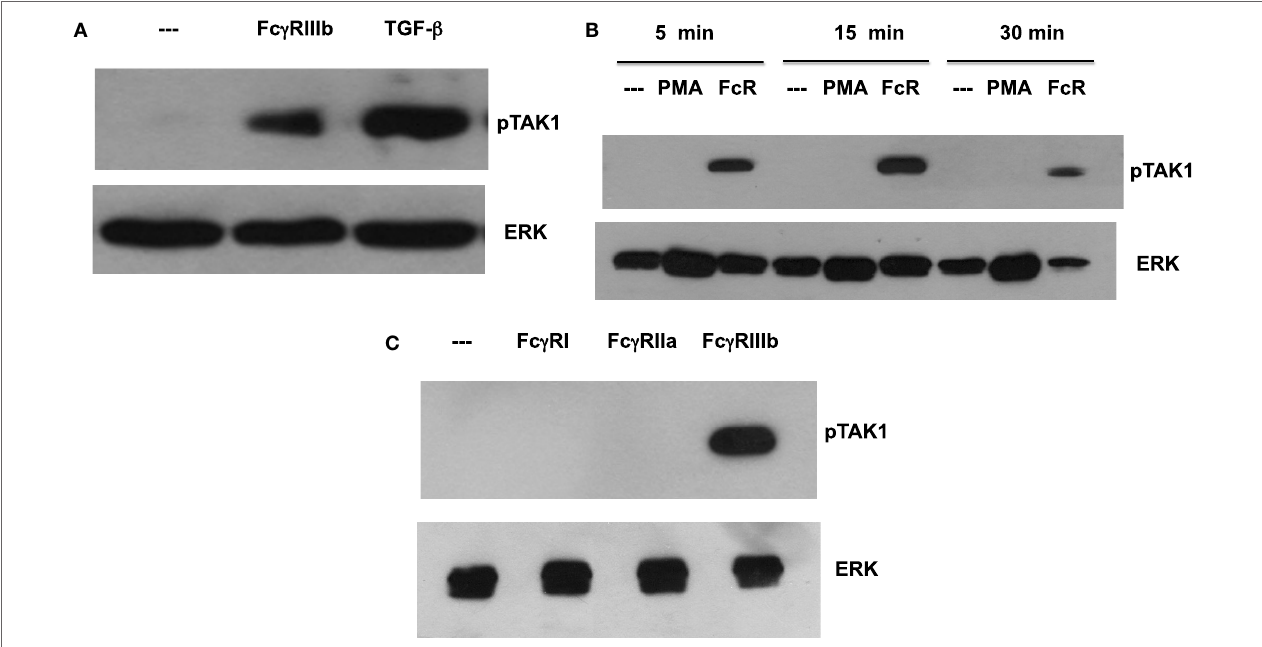
FigUre 4 | Fc γ r-cross-linking induces activation of TaK1 . Human neutrophils were left untreated (---), or (a) were stimulated with 5 ng/ml transforming growth factor- β (TGF- β ), or by cross-linking Fc γ RIIIb for 15 min. (B) neutrophils were also stimulated with 20 nM phorbol 12-myristate 13-acetate (PMA), or by cross-linking Fc γ RIIIb (FcR) for 5, 15, and 30 min. (c) neutrophils were also stimulated by cross-linking Fc γ RI with mAb 32.2, by cross-linking Fc γ RIIa with mAb IV.3, or by cross-linking Fc γ RIIIb with mAb 3G8 for 15 min. Cell lysates were prepared after stimulation. Proteins were resolved by SDS-PAGE, and then Western blotted for phosphorylated-TAK1 (pTAK1) (upper panel) or for total ERK (lower panel). Data are representative of three separate